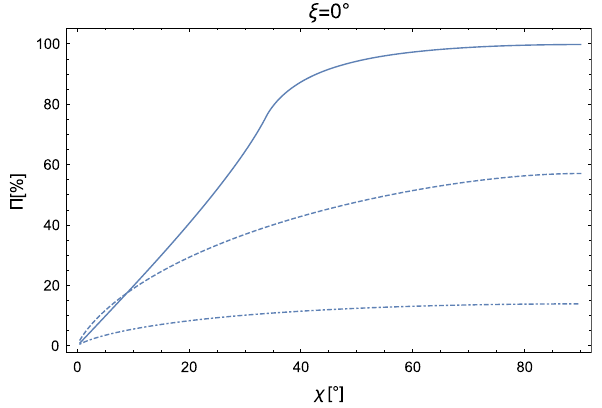
Fig. 2 χ is the angle between the rotation axis of the star and the observation line. ξ is the angle between the rotation and magnetic axes. (cid:4) (cid:11) = Q 2 + U 2 / I is the polarization degree as a function of the two Stokes parameters Q and U , whereas I is the total intensity. An average over the period of rotation is done. Dashed lines correspond to the case of no QED effects with a meridian magnetic field. Dot-dashed lines are for the case of no QED effects and a dipole magnetic field . Solid lines are obtained including the vacuum birefringence effect (with a dipole magnetic field). The results agree almost everywhere, within experimental errors, with those given in [1]. However, as discussed in thetext,ourinterpretationofthisresultremainsdifferent.Littlevariation is found at higher values of ξ (cid:2) 10